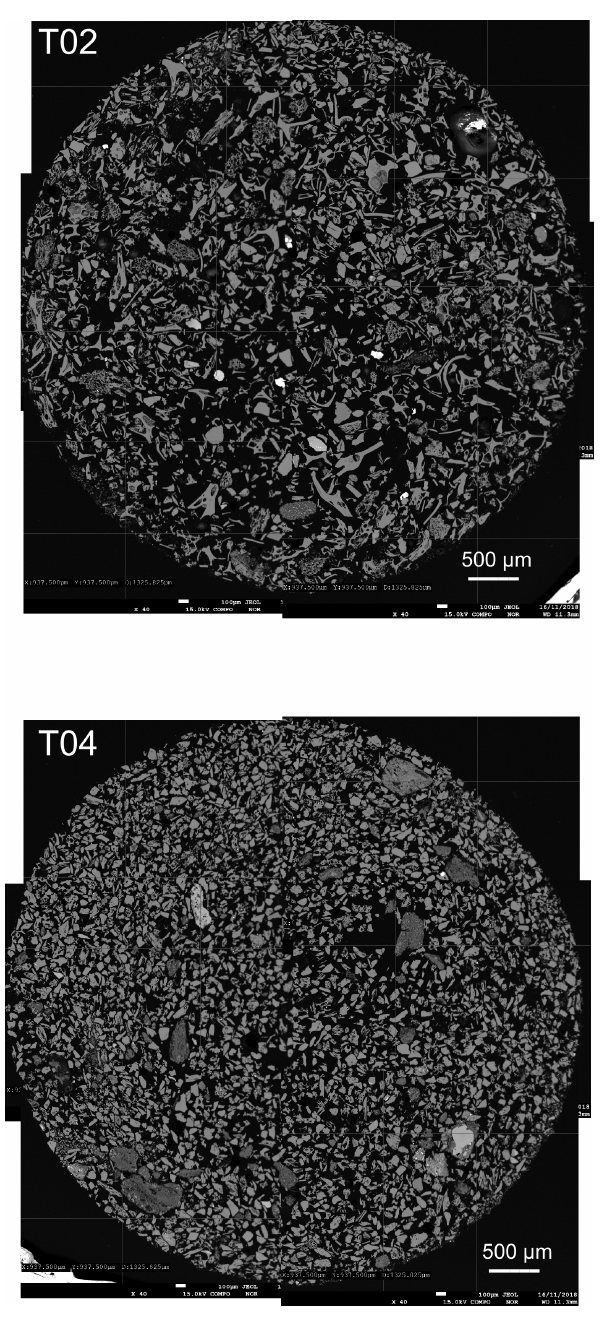
Figure A2. Backscatter images of samples T02 and T04. The large cuspate shards with preserved thin bubble walls in T02 signify a very large, very explosive eruption, in comparison to the small blocky shards in T04, suggesting a smaller, less explosive eruption.